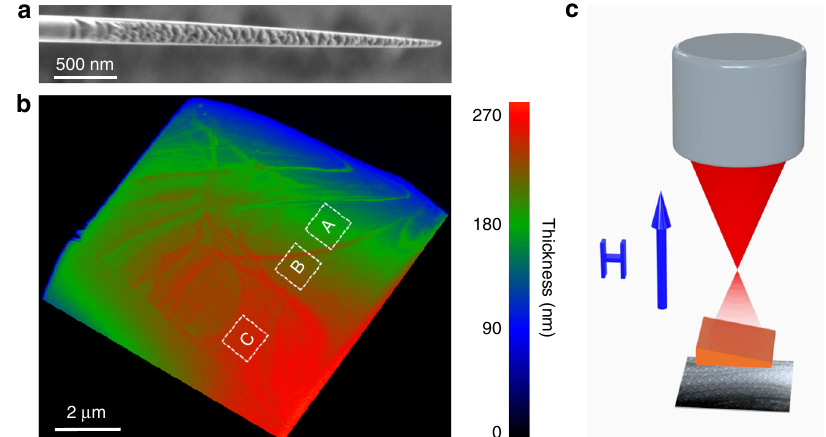
Fig. 1 Wedge-shaped lamella of single crystalline Mn 1.4 Pt 0.9 Pd 0.1 Sn. a Cross-sectional view of a scanning electron microscopy (SEM) image of the wedge- shaped lamella. b 2D thickness map of the lamella obtained from electron energy loss spectroscopy (EELS) measurements. The three white dashed boxes indicate three regions of different thicknesses (A: 164 nm < t < 197 nm; B: 213 nm < t < 229 nm and C: 246 nm < t < 250 nm), that were used to construct thickness-dependent magnetic phase diagrams. Note that the length of the wedge in fi gure a can be estimated from the scale bar by taking into account a 36° tilt. c Schematic drawing of the LTEM experimental set